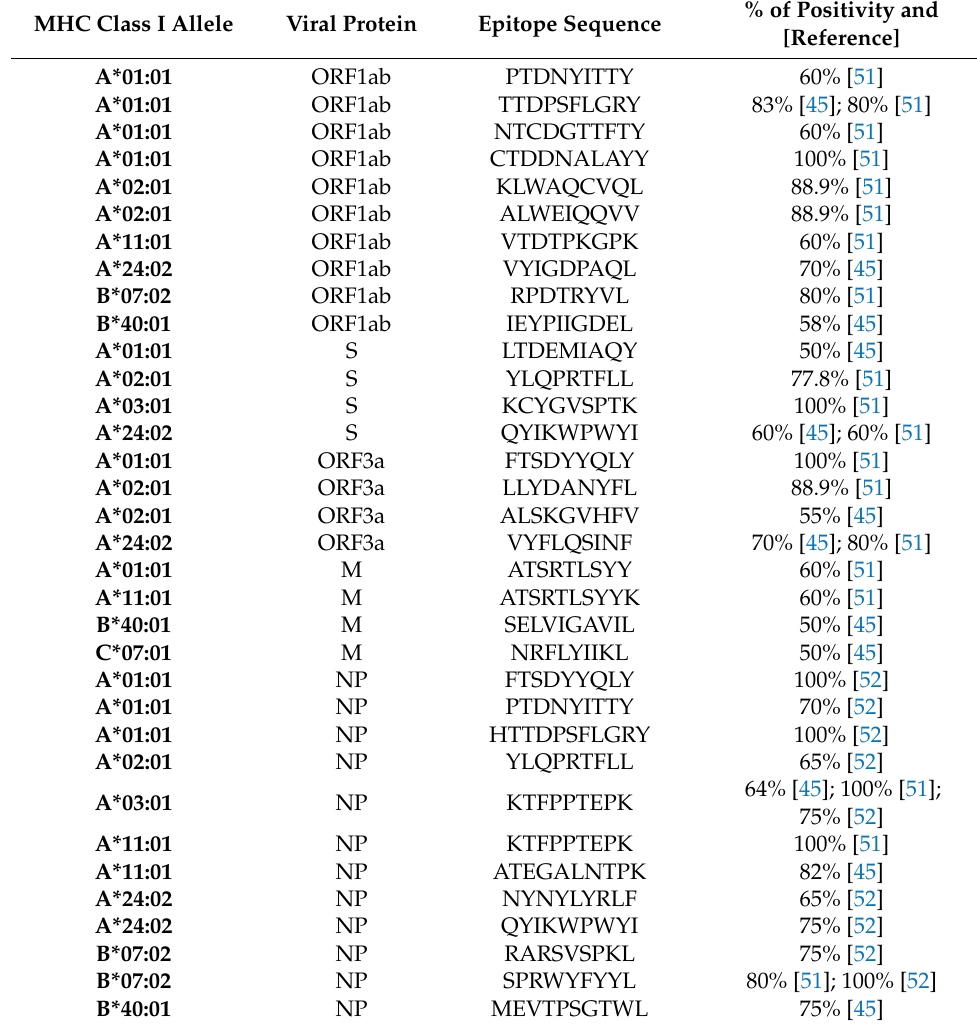
Table 1. Most common SARS-CoV-2 CD8 + T-cell epitopes in humans a . MHC Class I Allele Viral Protein Epitope